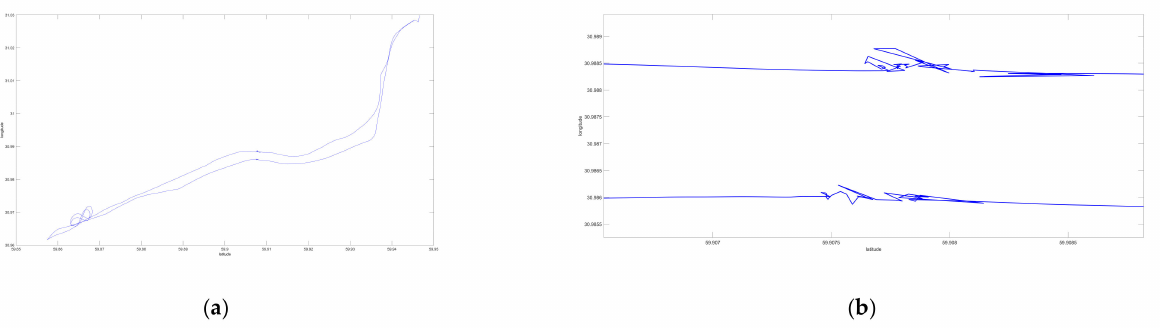
Figure 5. Vessel trajectory ( a ); trajectory under the bridge, the result of post-processing the signal ( b ). To train the neural network, an array of 1000 lines containing latitude and longitude was taken (see Table 2 for data sample). Table 2. Input data